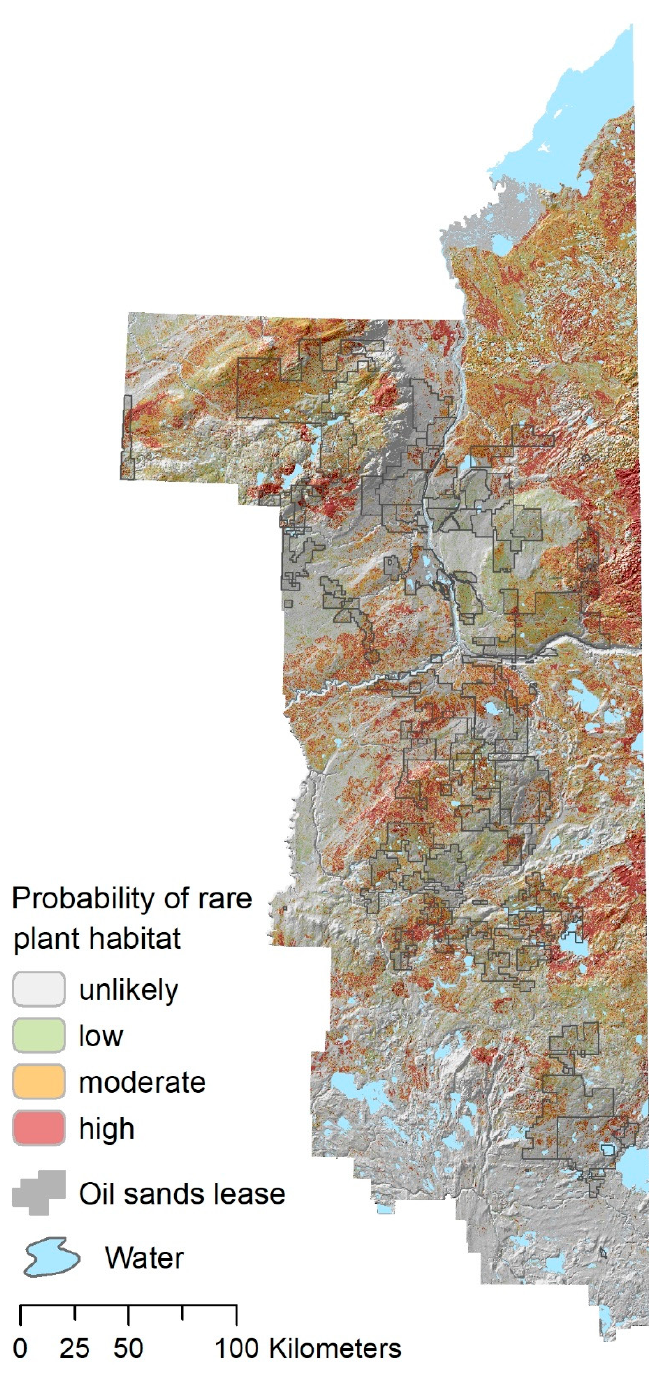
Figure 4. Predicted distribution of rare vascular plant (S1 or S2 conservation rank) habitat within the Lower Athabasca of northeast Alberta, Canada. Prediction classes are based on model sensitivity (true positive rate), specificity (true negative rate), and optimal threshold classification probability where sensitivity and specificity are equalized. Both ‘unlikely’ and ‘low’ classes had model probabilities lower than the optimal threshold; the ‘unlikely’ class had a model specificity ≥ 0.9, while the ‘low’ class had model specificity < 0.9. In contrast, the ‘moderate’ and ‘high’ classes both had model probabilities higher than the optimal threshold probability, with the ‘moderate’ class having sensitivity < 0.9 and the ‘high’ class having a model sensitivity > 0.9 indicating higher confidence in a rare plant being present. Oil and gas lease boundaries, which represent areas wherein rights have been granted to companies by the crown for exploration and resource development, current to 2015, are shown.